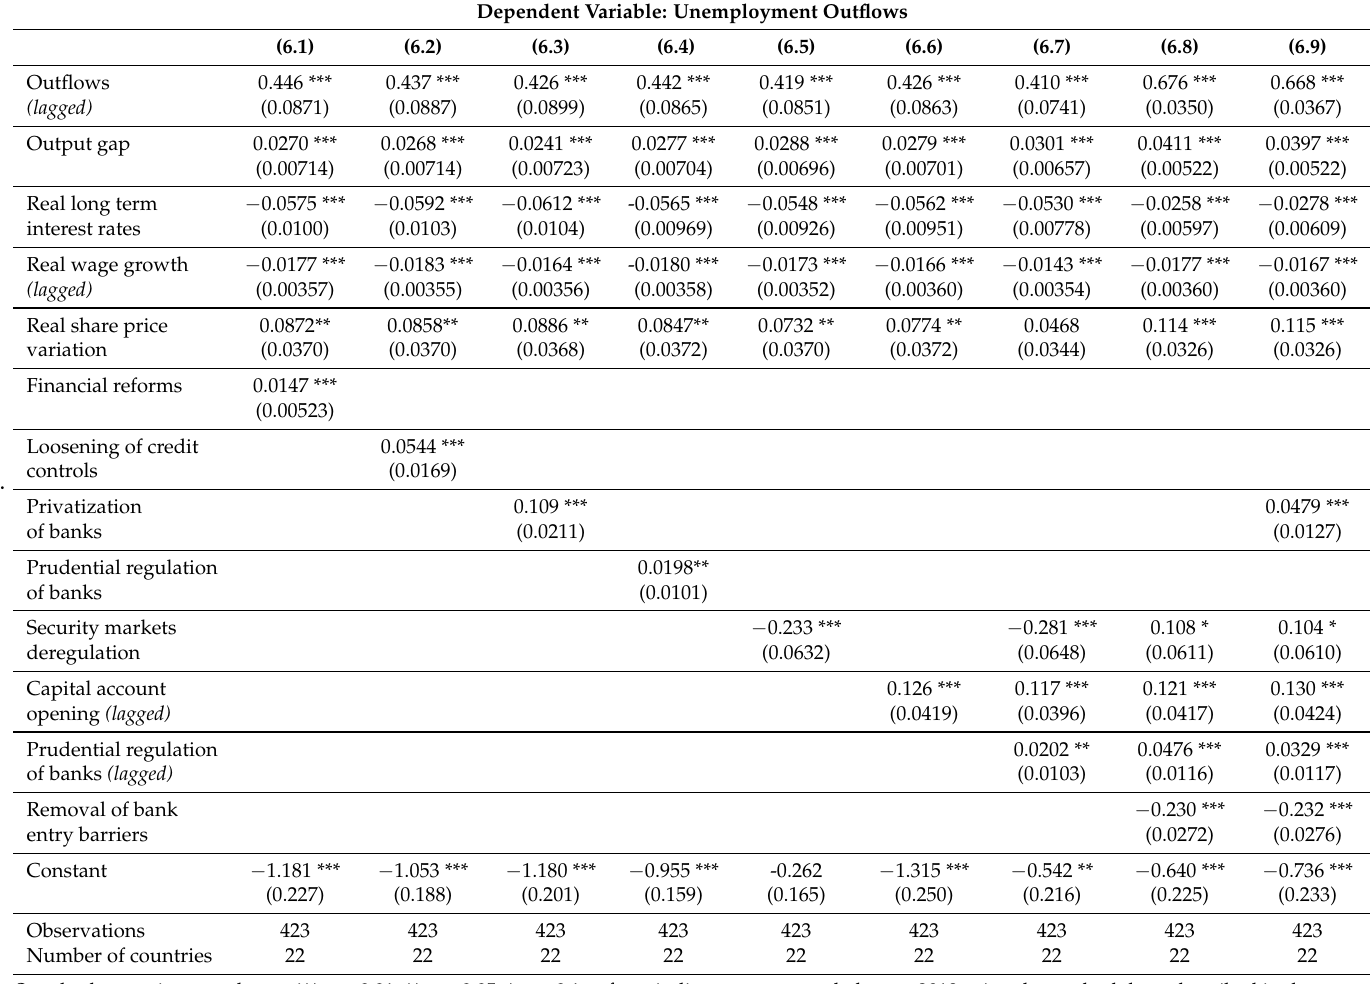
Table 6. Robustness check: financial sector reforms and unemployment